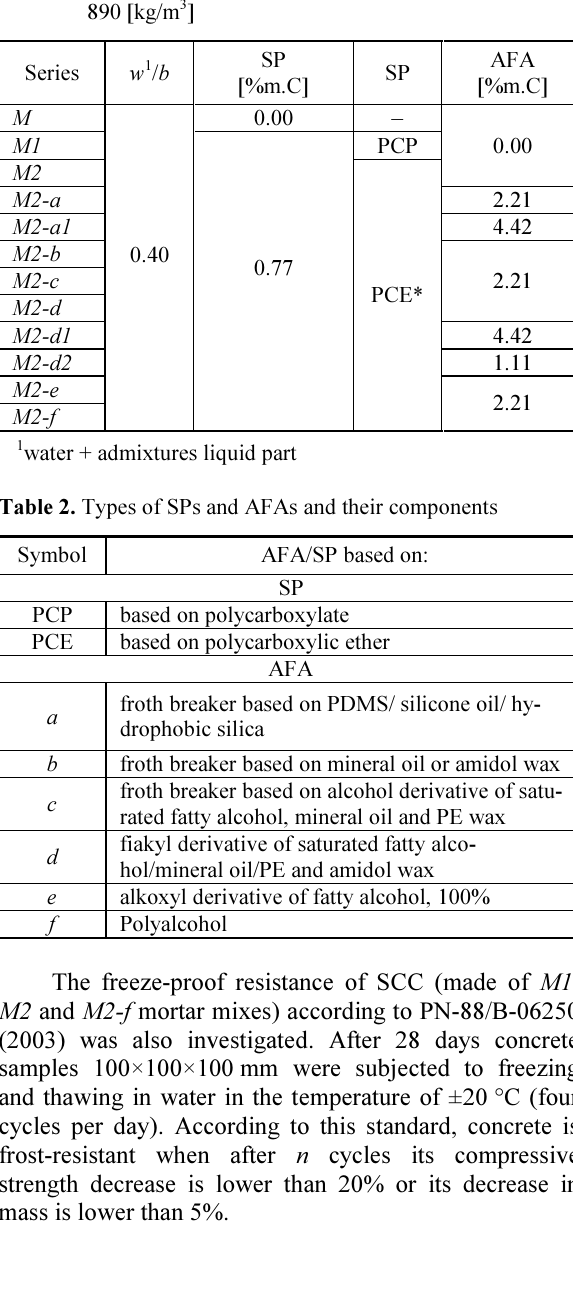
Table 1. Composition of mortar mixes ( M ); cement CEM II